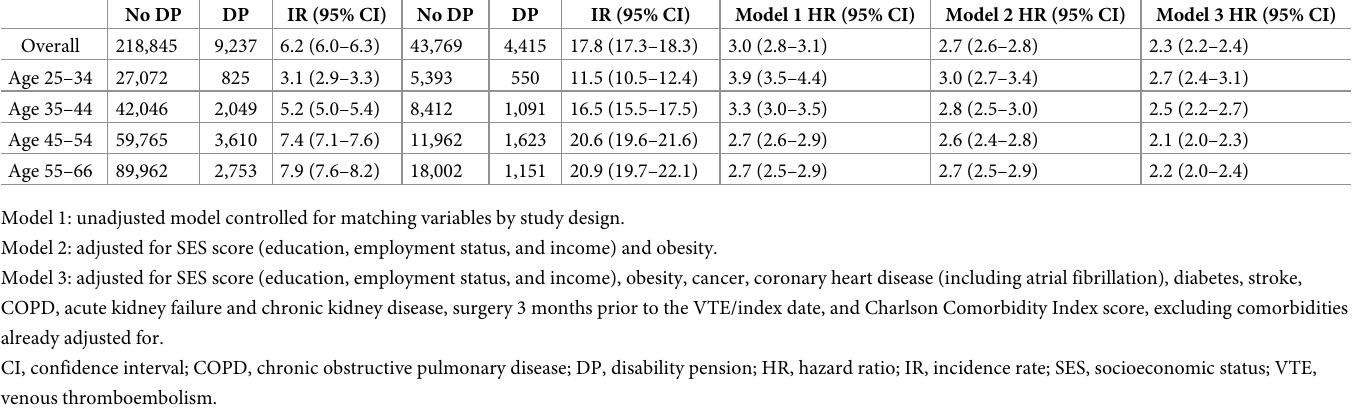
Table 2. IRs and HRs with 95% CIs by age for receipt of a work-related DP among persons with and without VTE. Comparison cohort